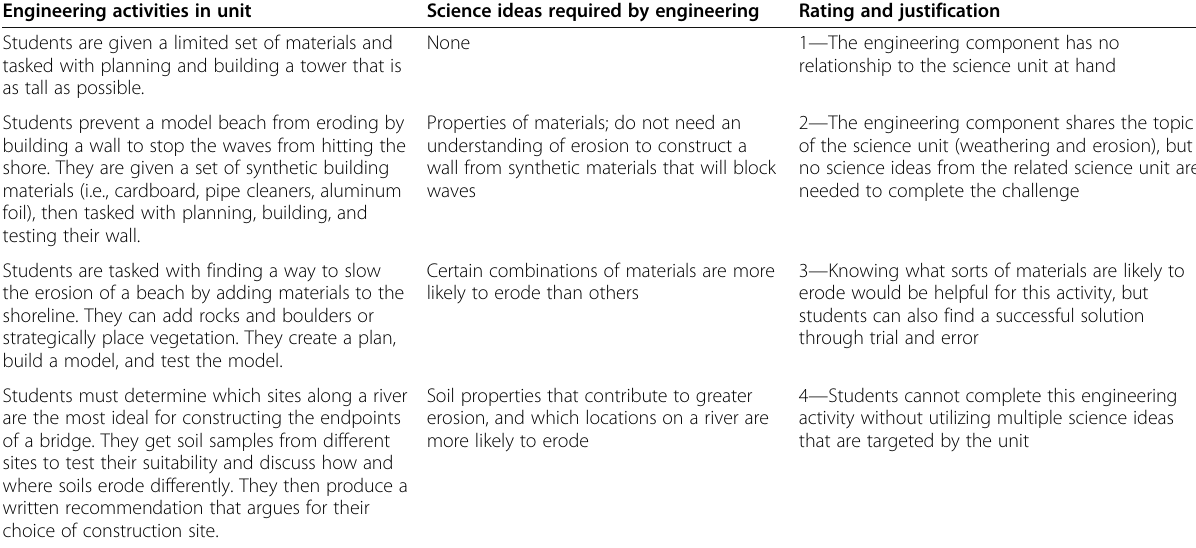
Table 3 Coding examples for ratings of connections between engineering and science Engineering activities in unit